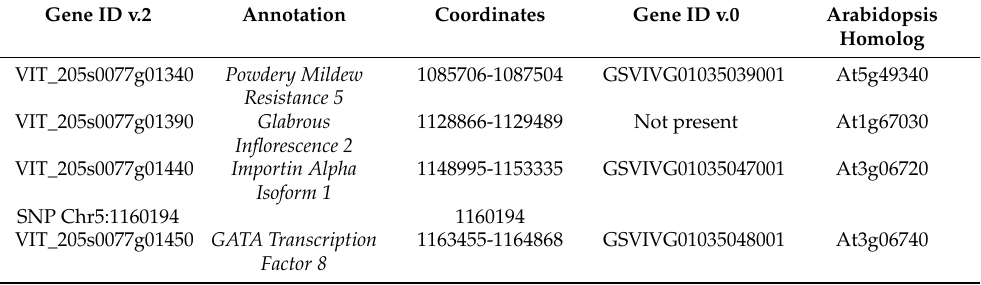
Figure 3. The graphical display of the correlation matrix for the measured phenotypes. All phenotypes displayed are accession means: Upper triangle: plotted relationships of the measured phenotypes. For box and whisker plots, the box represents the 25th and 75th percentiles, the bar represents the median, and dots are outliers beyond the quartiles. N = neither hairs nor bristles, B = bristles only, H = hairs only, HB = hairs and bristles. Lower triangle: Pearson’s correlation coefficients. Positive correlations are displayed in blue and negative correlations in red. Color intensity and the size of the circle are proportional to the correlation coefficients. Stars denote “holm” corrected p -values (*** < 0.001, ** < 0.01). Diagonal: density distributions of the phenotypes. Table 2. Genes of interest and their locations relative to the SNP significantly associated with domatia density. The coordinates for each gene and the SNP of interest are listed sequentially. Genes within ± 10 kb of the SNP are in